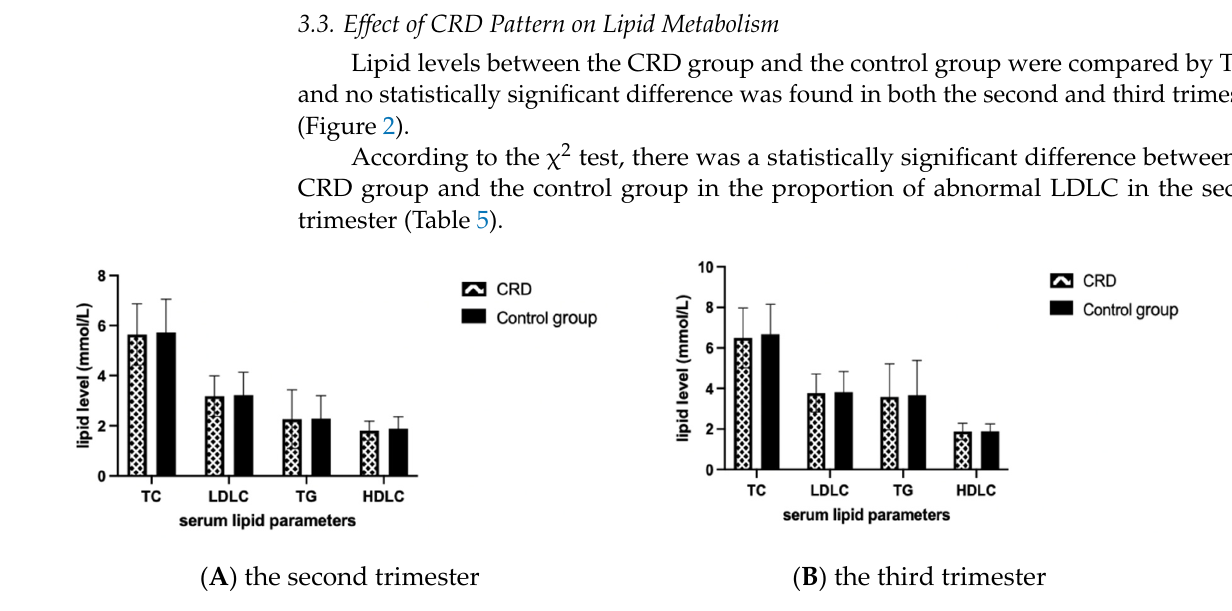
Figure 2. Comparison of lipid-related indexes between the two groups. Mean and SD of TC, TG, HDLC and LDLC levels in the second and third trimester in each group are presented in panel ( A ) and ( B ), respectively. TC, total cholesterol; TG, triglyceride; HDLC, high-density lipoprotein cholesterol; LDLC, low-density lipoprotein cholesterol. Table 5. Comparison of dyslipidemia rate between the two groups.